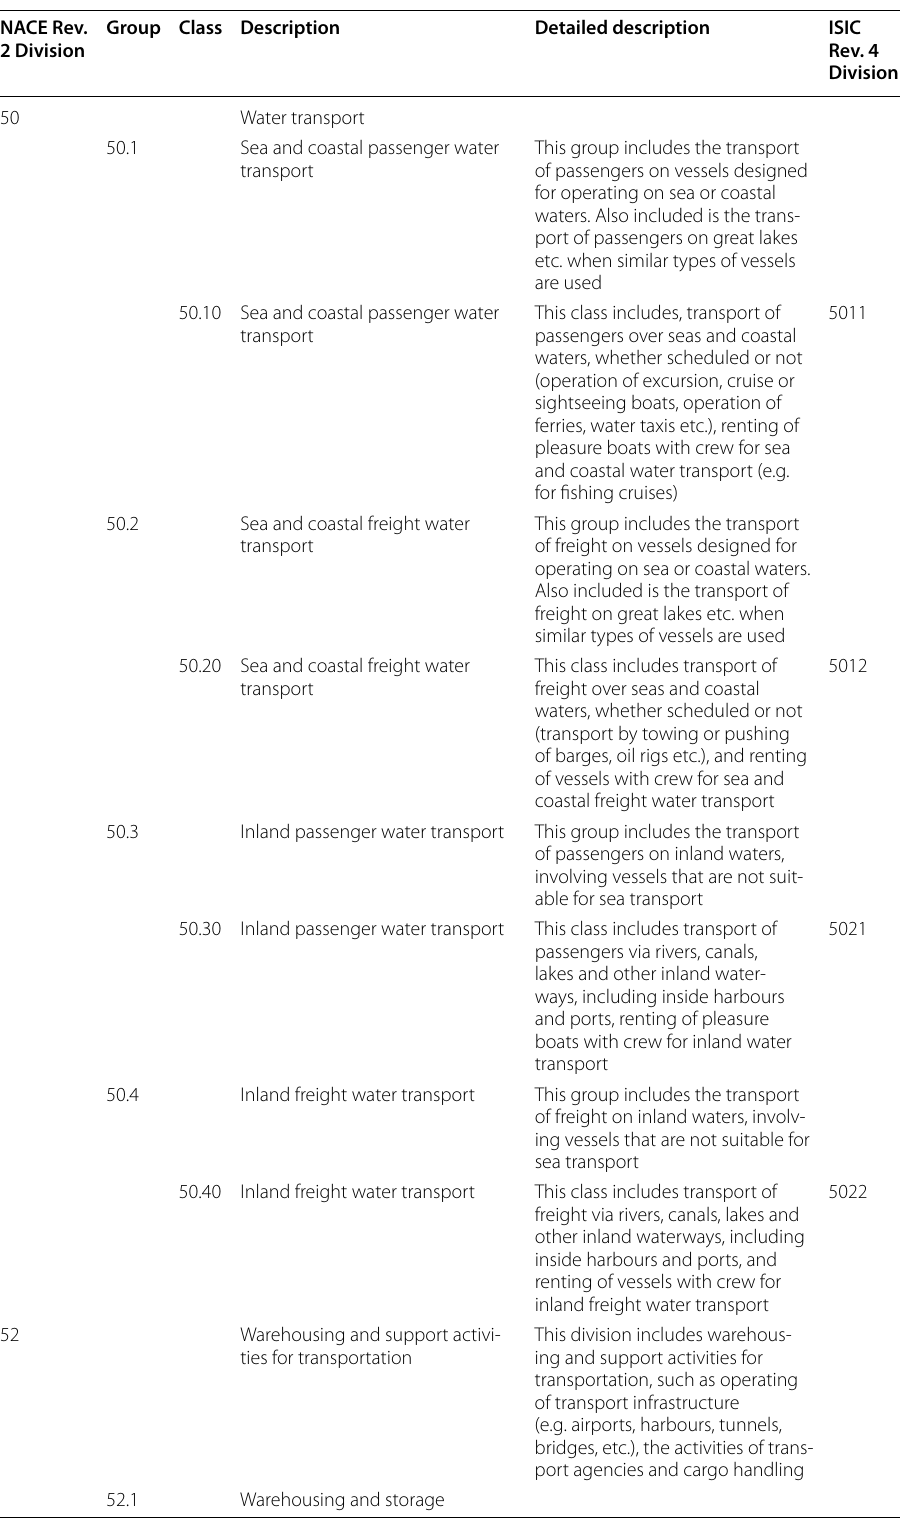
Table 4 Shipping divisions used in the model Section H – Transportation and